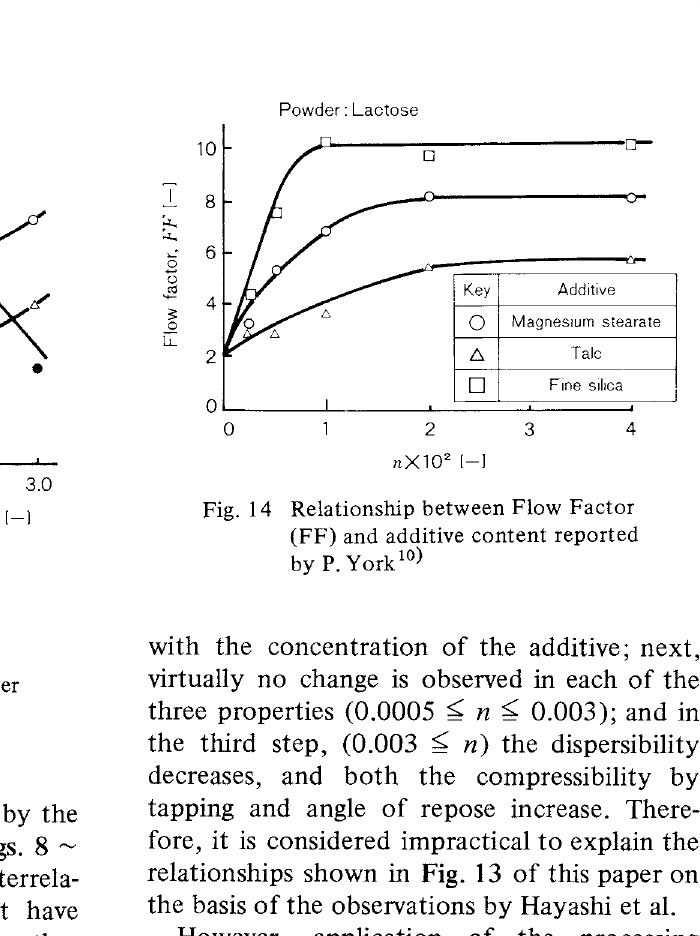
Fig. 13 Effect of additive on mechanical properties of potato starch powder reported by Hayashi et al. 1 )